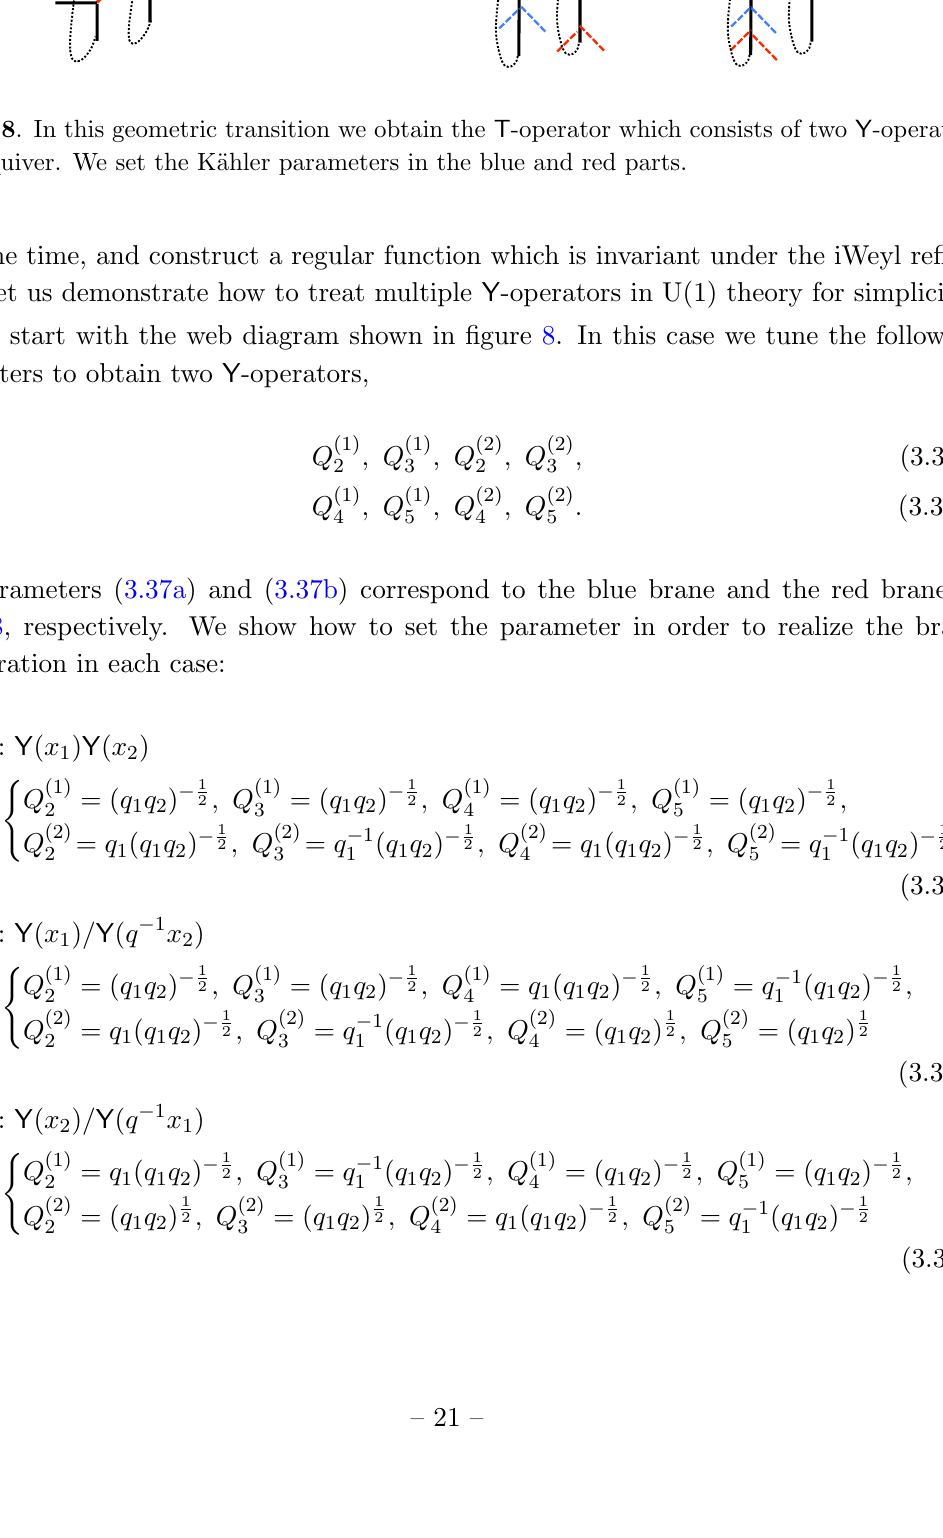
the same time, and construct a regular function which is invariant under the iWeyl